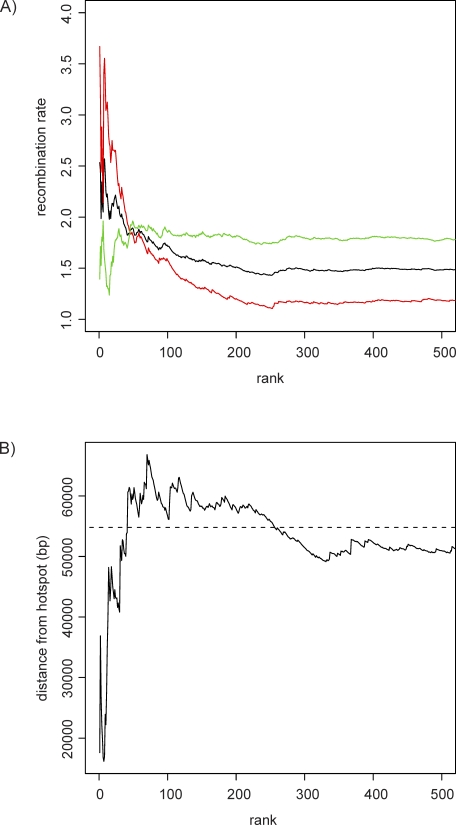
Cumulative Average Human Recombination Rate in the Regions Surrounding the Most Accelerated Exons(A) Cumulative average male (red), female (green), and sex-averaged (black) recombination rates.(B) Cumulative average distance to the nearest recombination hotspot.The dashed line represents the average for the entire dataset.